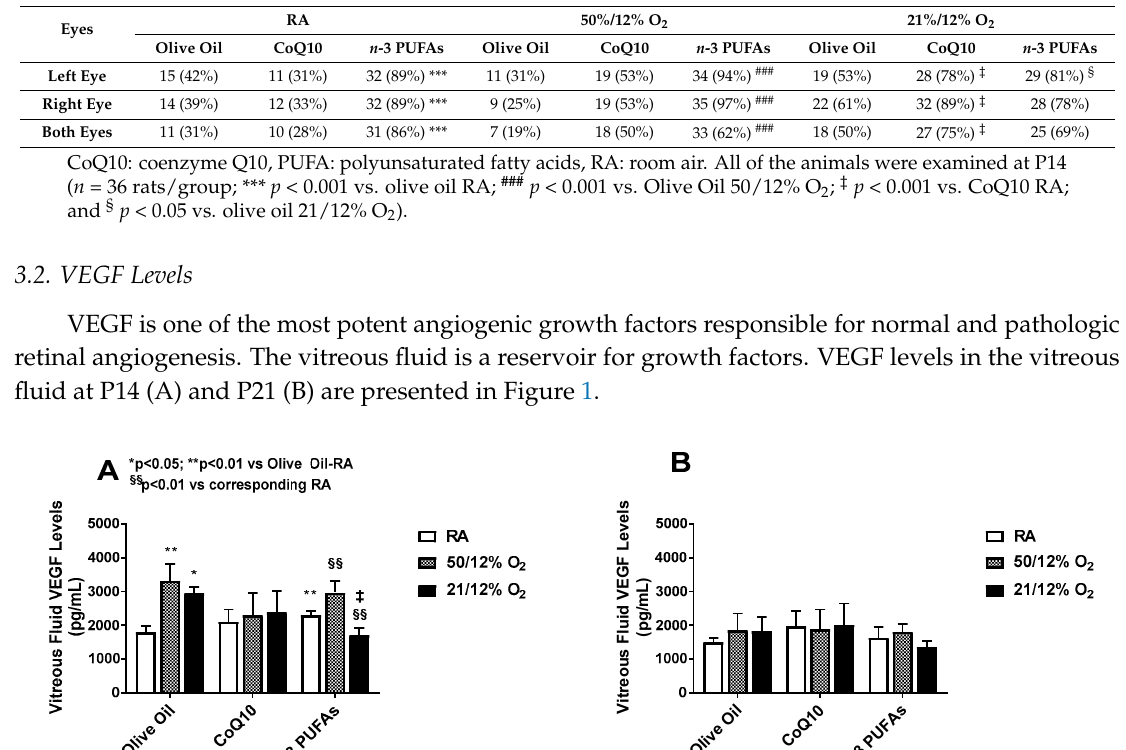
Table 1. Eye-Opening at Postnatal Day 14 (P14).